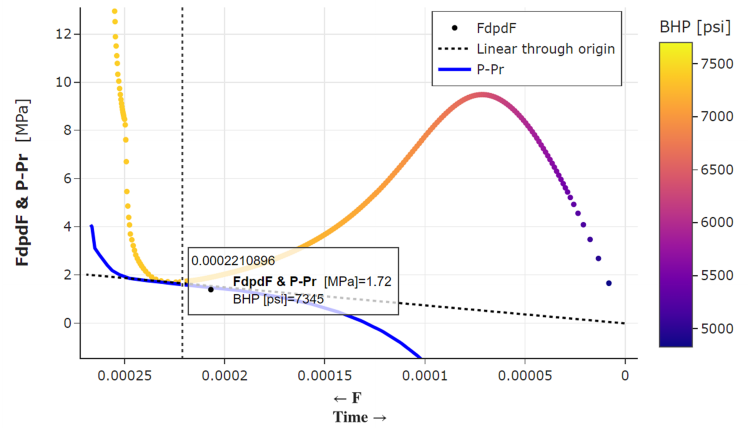
Figure 10. F-function plot for the simulated case.